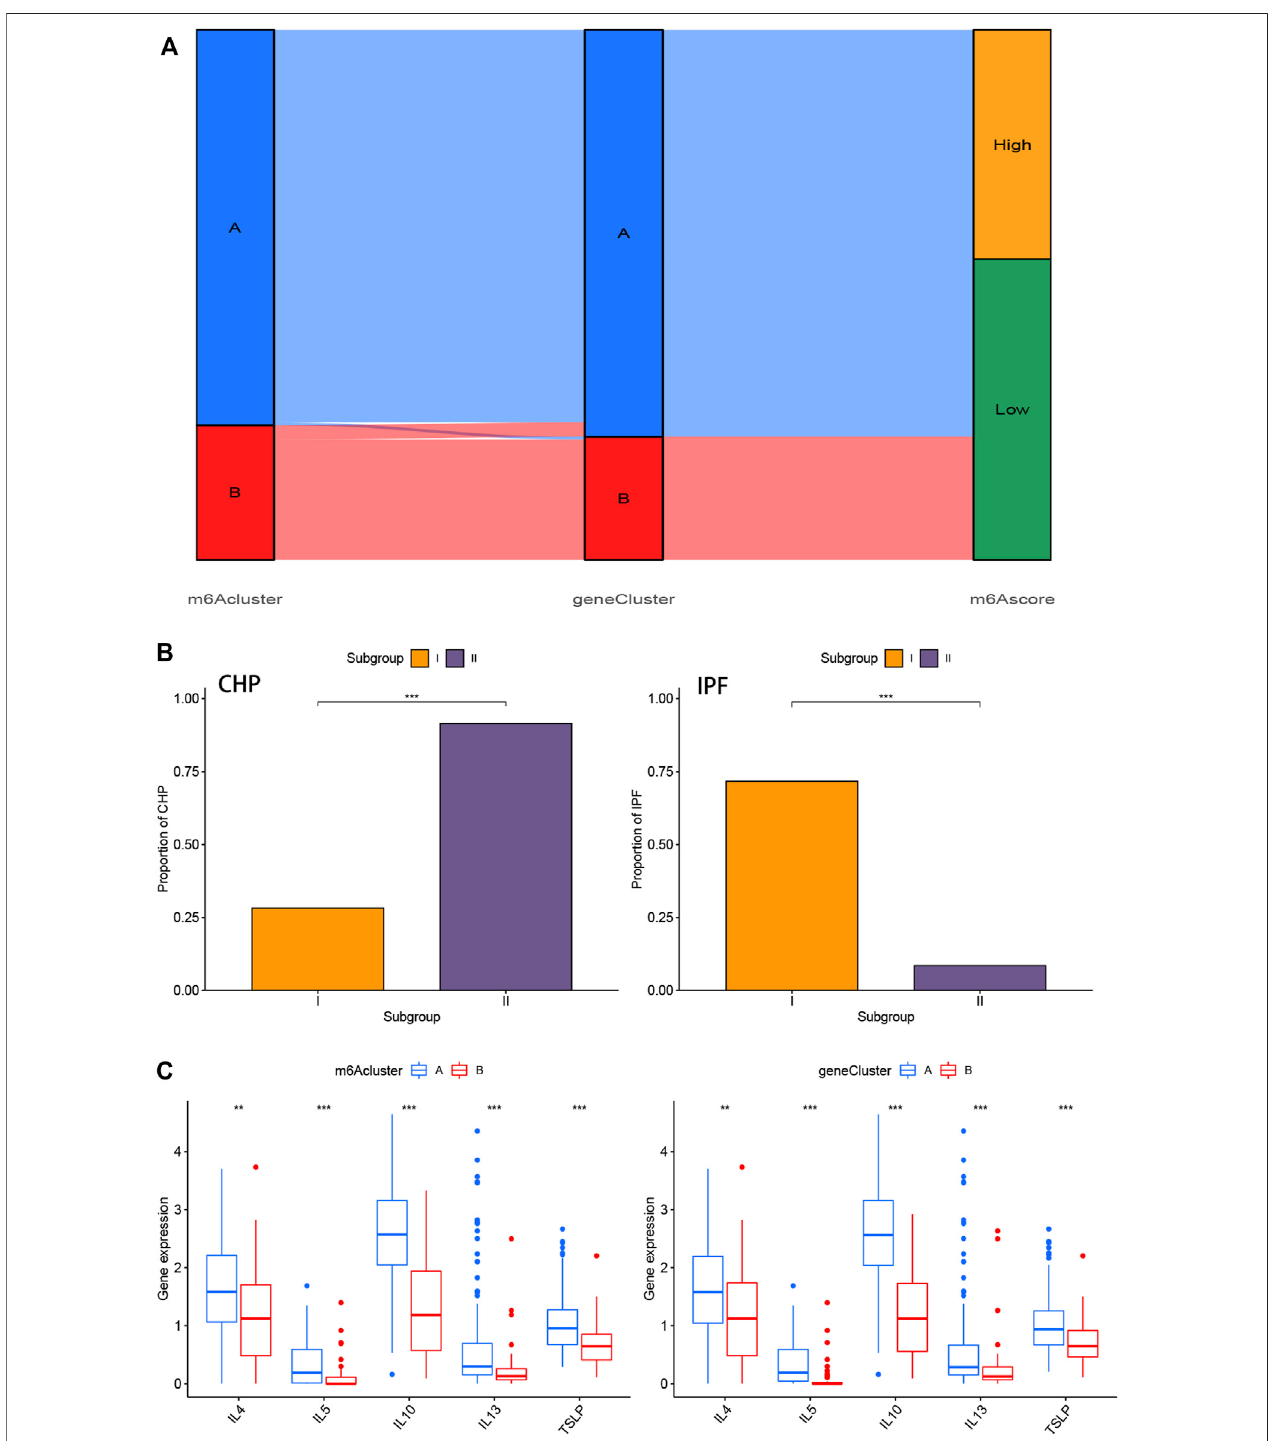
FIGURE 8 | Role of m6A patterns and gene patterns in distinguishing pulmonary fi brosis (A) Sankey diagram of the relationship between two m6A patterns, two gene patterns, and m6A scores. (B) Correlation between m6A patterns and clinical types. The samples were divided into 2 groups (Subgroup I and II) based on m6A patterns,oneforeachofthem6AclusterAandm6AclusterB.ThedistributionofCHPintwom6Apatternswasshownontheleft,whilethedistributionofIPFwasshown ontheright (C) Differentialexpressionlevels ofinterleukin (IL)-4,IL-5, IL-10,IL-13andthymic stromallymphopoietin(TSLP)betweenm6AclusterAandm6Acluster B or gene cluster A and gene cluster B. * p < 0.05, ** p < 0.01, and *** p < 0.001.